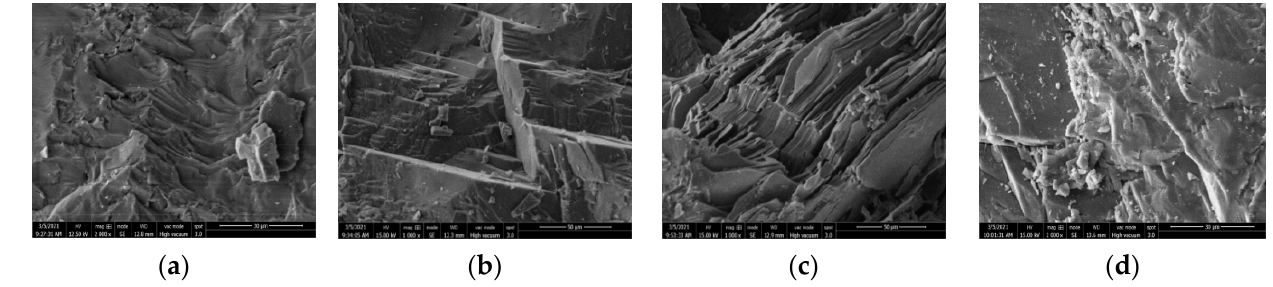
Figure 14. Typical microscopic morphology of flaky exfoliated fragments. ( a ) Broach-step pattern; ( b ) Step pattern; ( c ) Step pattern; ( d ) Stepped flowers.